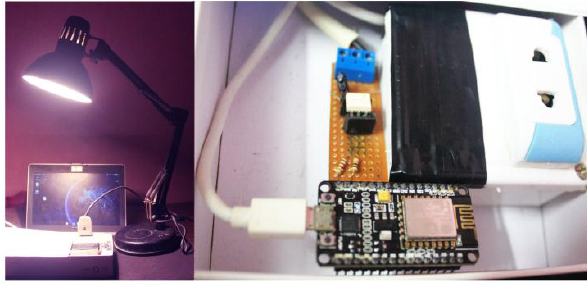
Figure 4. Prototype of the IoT Switching Model